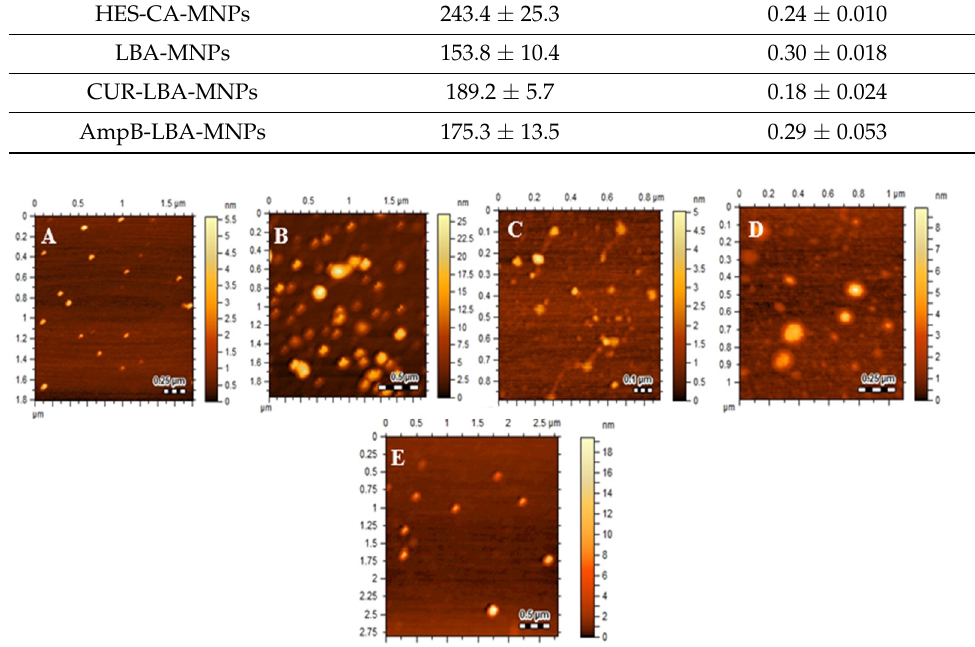
Figure 3. Atomic force microscopic images of ( A ) LBA-MNPs, ( B ) CA-MNPs, ( C ) HES-CA-MNPs, ( D ) CUR-LBA-MNPs, and ( E ) AmpB-CA-MNPs.